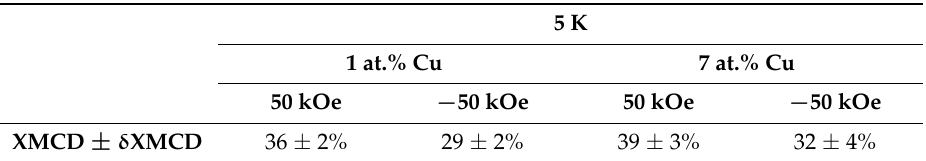
Table 2. Relative XMCD signals and corresponding errors of the SnO 2 powders doped with 1 and 7 at.% Cu measured at 5 K under 50 and − 50 kOe. See supplementary information for details on the calculation of the XMCD signal and its error.